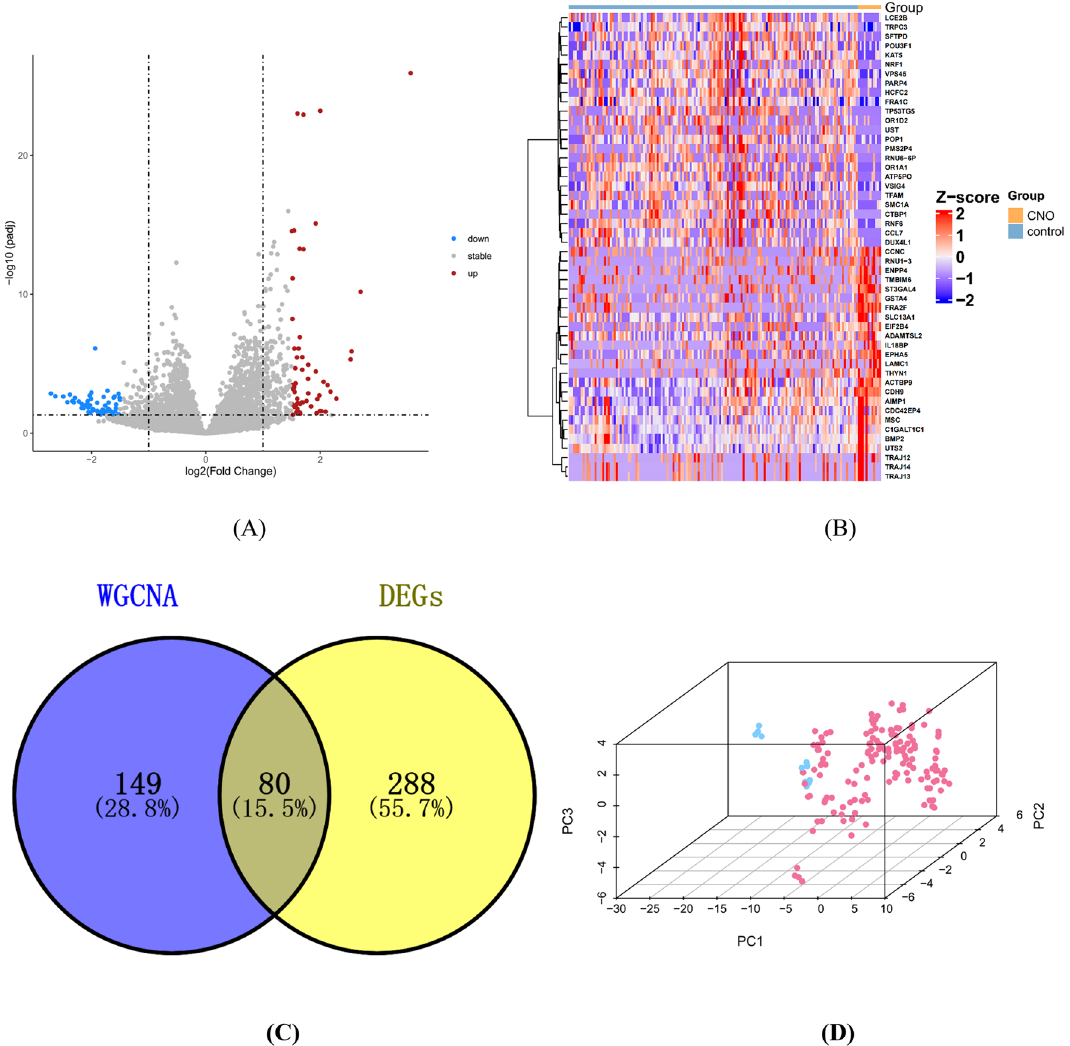
Figure 3. Identification of DEGs and CNO-related genes. ( A ) Volcano plot: The red points represent upregulated genes, and blue points represent downregulated genes. Genes with no significant difference are shown in grey. The threshold for differential expression was set as |log2 fold change|> 2 and adjusted P value < 0.05. ( B ) Heatmap: The heatmap of the top 25 upregulated genes and the top 25 downregulated genes; blue indicates relatively low expression, and red indicates relatively high expression. ( C ) Venn diagram: The DEGs and CNO-related module genes showed an overlap of 80 genes. ( D ) PCA: Dimension reduction analysis of the 80